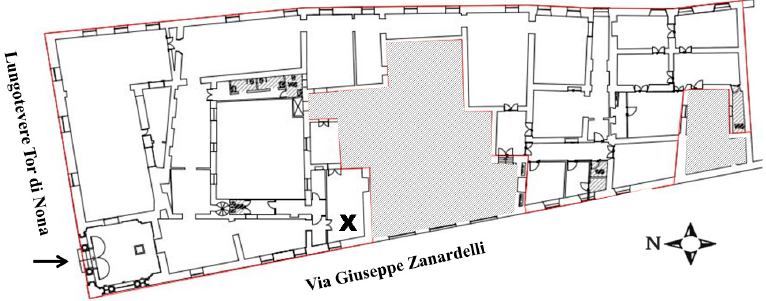
Figure 5. Plan of the Napoleonic Museum: the arrow refers to the entrance while the X locates the CleAir system. Such location was chosen to be enough internal in the museum, but relatively close to the main entrance to be affected by external conditions.